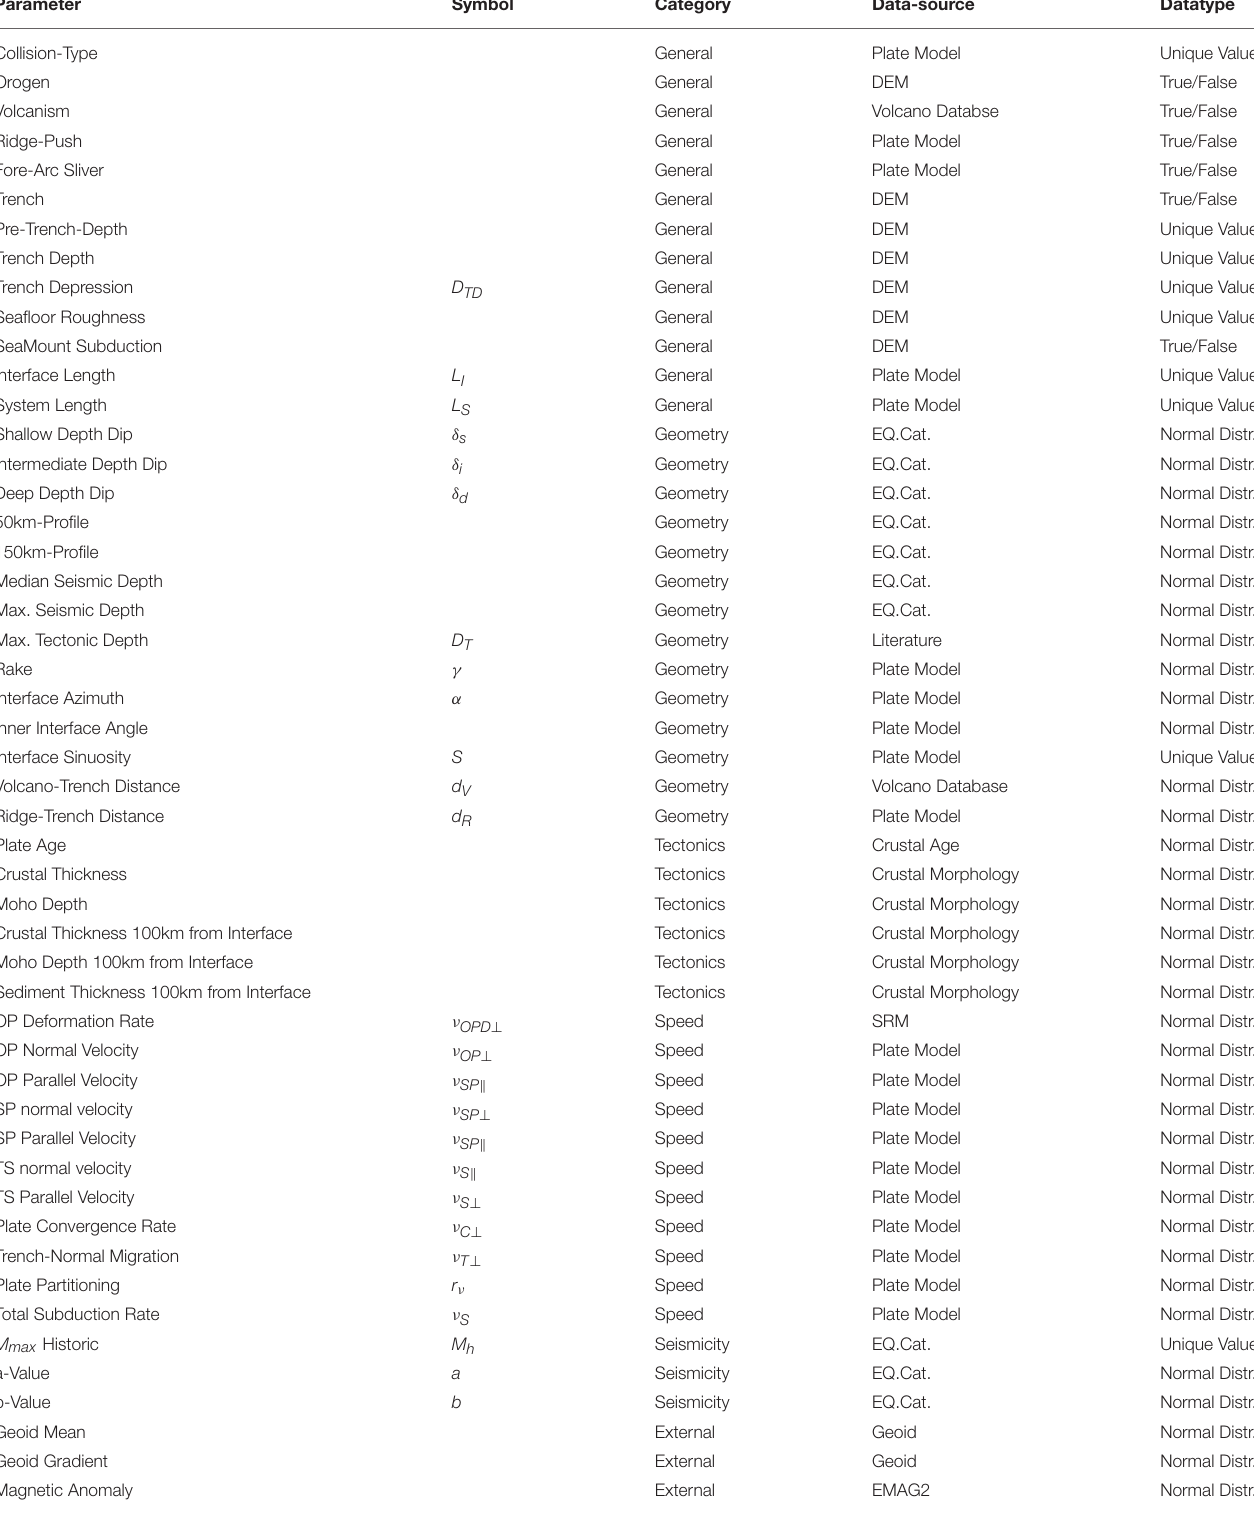
TABLE 2 | Overview of all parameters assessed within the subduction zone parameter